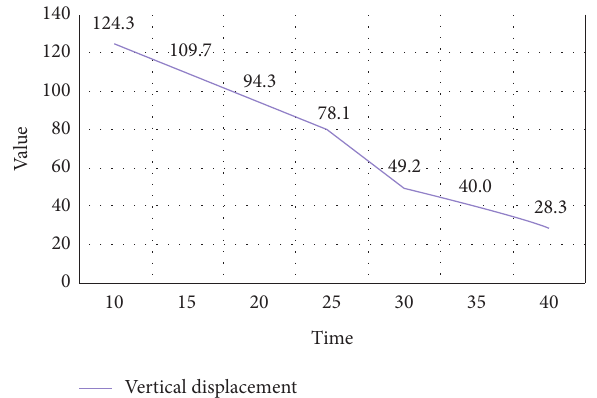
Figure 3: Frame settlement structure foundation settlement diagram.